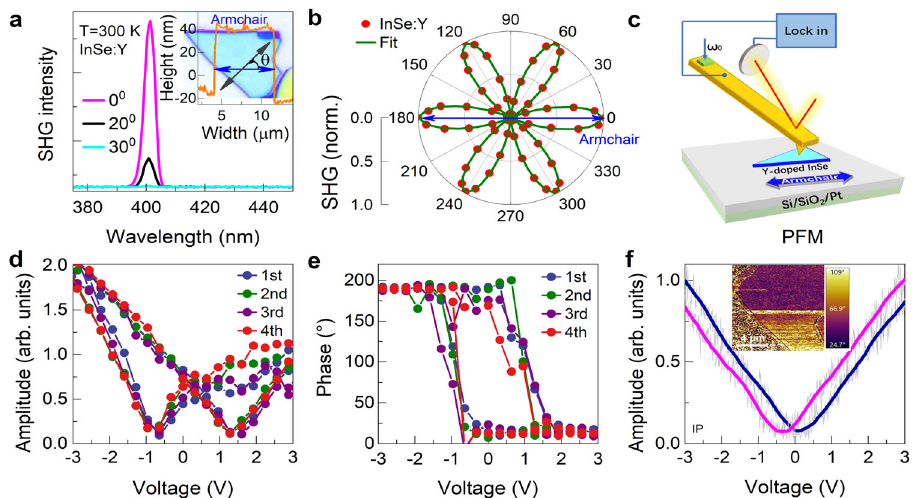
Fig. 3 | SHG and PFM of InSe:Y. a SHG intensity at angles of 0 0 , 20 0 , and 30 0 . The inset gives the exfoliated InSe:Y morphology with the thickness of ~50nm mea- suredbyatomicforcemicroscopy(AFM). b PolarplotsofSHGintensitiescollected by rotating the polarizer as a function of the detection angle. c Schemes of the